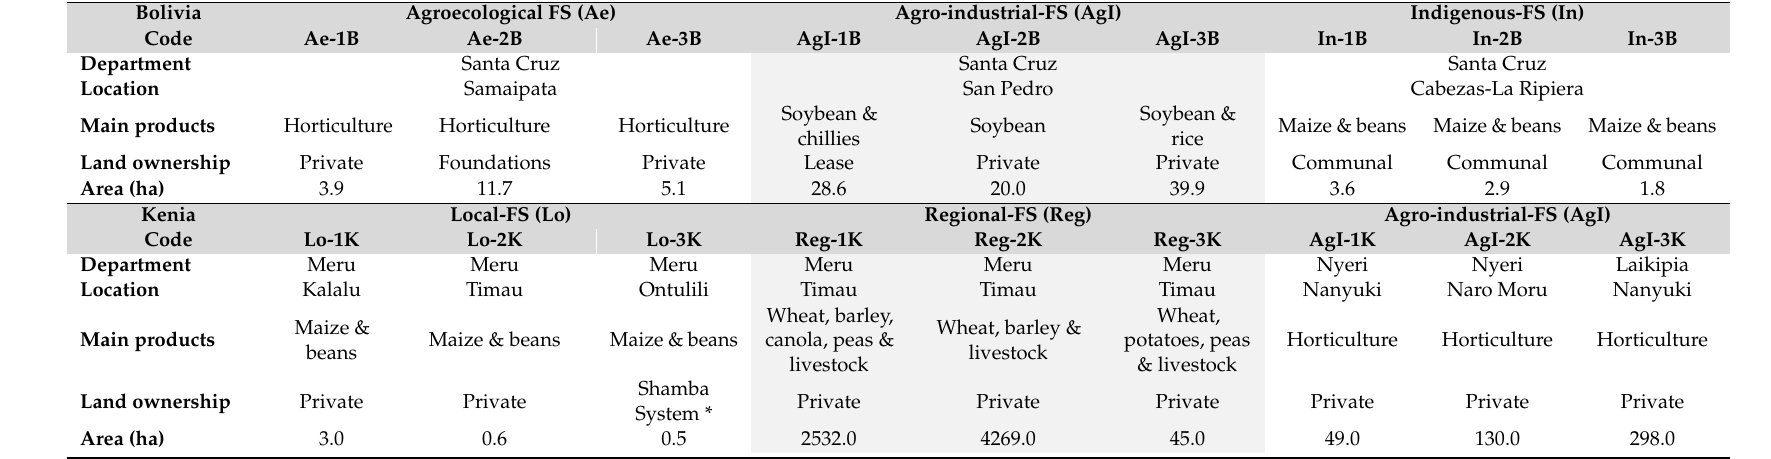
Table 2. Main characteristics of farm-based